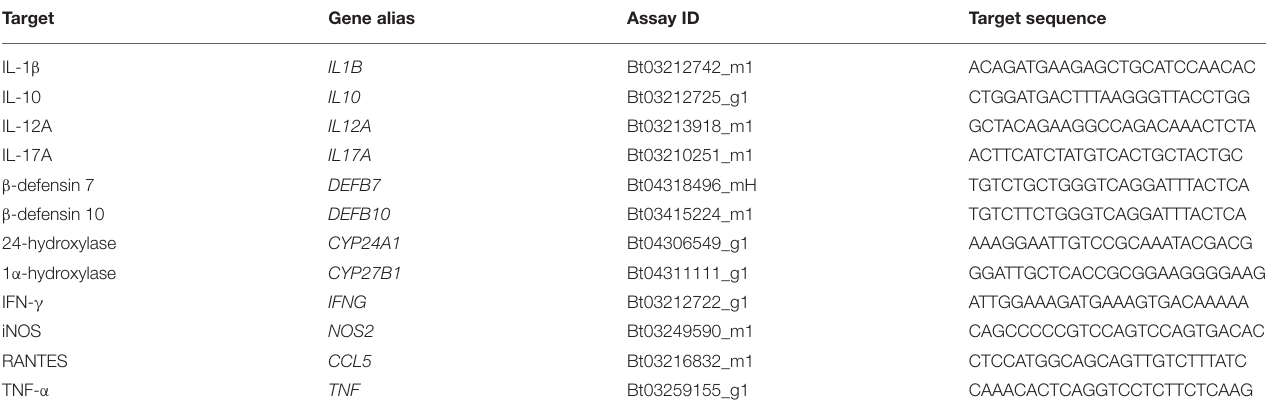
TABLE 2 | ThermoFisher scientific gene expression